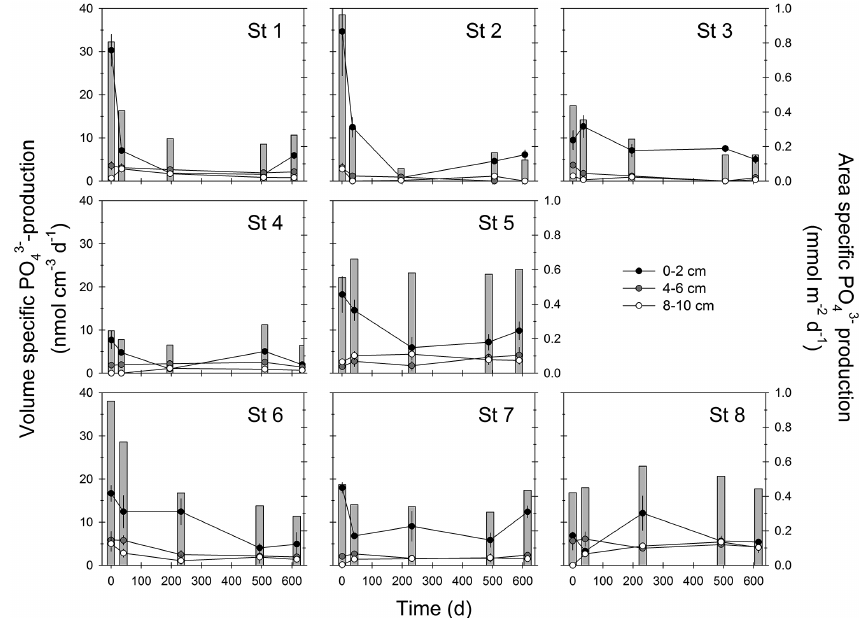
Figure 4. PO 3 − production measured in jar experiments performed with sediment from shallow inner fjord (upper panels), shallow silty 4 and sandy outer fjord (middle panels) and deep silty outer fjord (lower panels). Black, gray and white symbols indicate volume-specific PO 3 − production in sediment from 0–2, 4–6 and 8–10cm depth, respectively (left y axis). Bars indicate depth-integrated (0–20cm) PO 3 − 4 production based on volume-specific production rates (right y